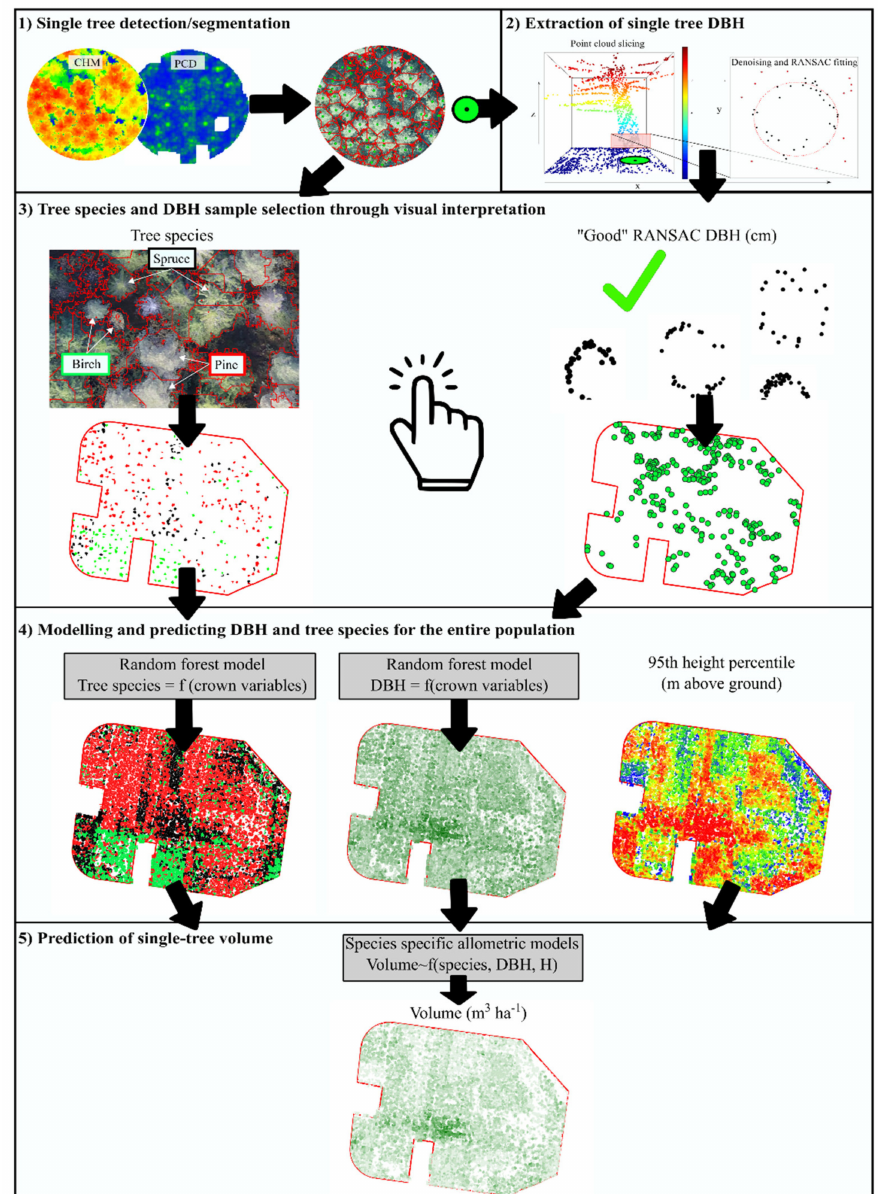
Figure 3. Schematic representation of the proposed method to predict single tree V (m 3 ) from UAV-LS data. In step 3, the points represent the individual trees for which the diameter at breast height (DBH) was classified as reliable through a visual